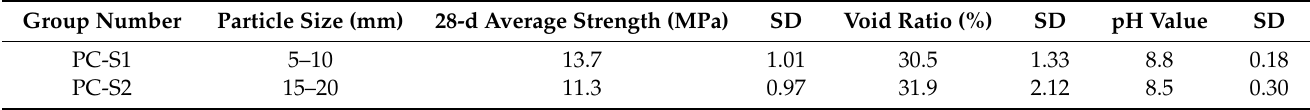
Table 4. Void ratio, alkalinity, and mechanical